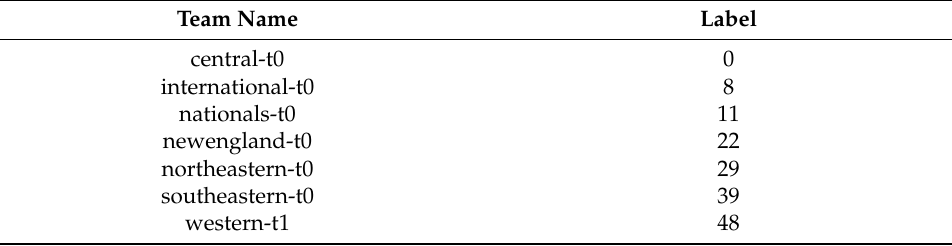
Table 6. Team names with corresponding